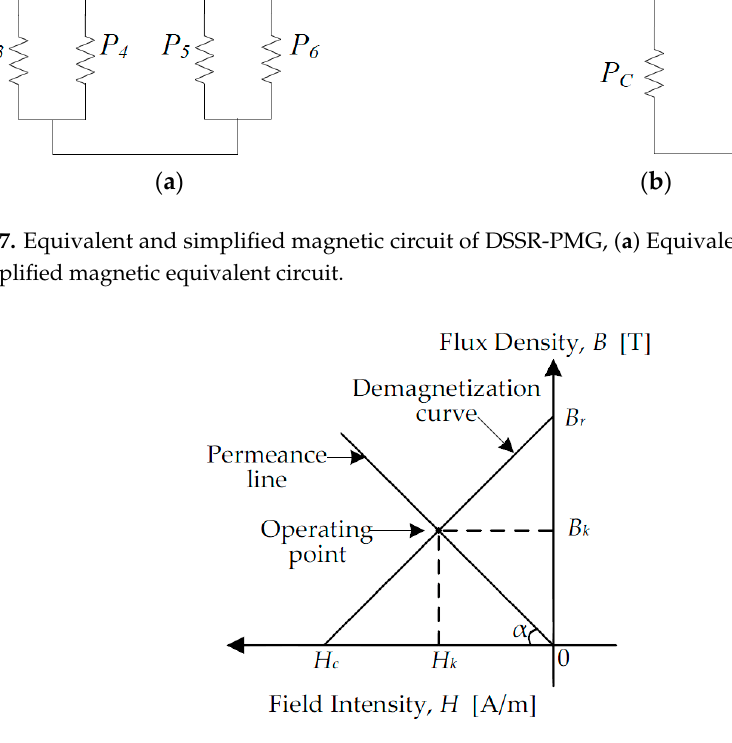
Figure 8. B-H curve and operating point of permanent magnet.